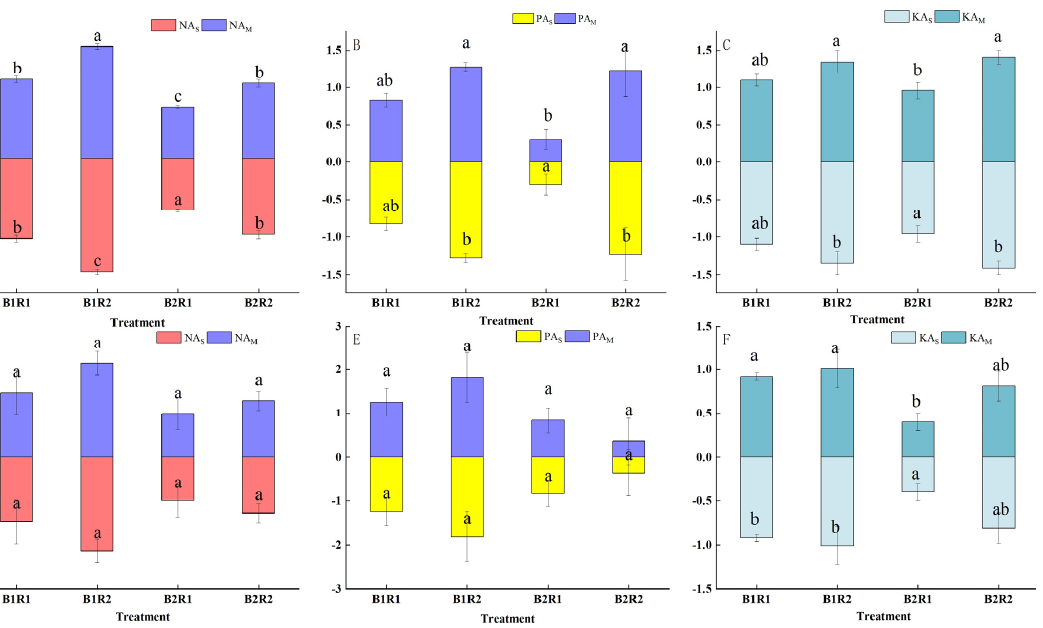
Figure 5. Nutrient aggressivity of maize–soybean intercropping systems. ( A – C ) represent intercropped maize and intercropped soybean N, P, and K aggressivities in 2018, respectively. ( D – F ) represent intercropped maize and intercropped soybean N, P, and K aggressivities in 2019, respectively. lowercase letters above the bars indicate significant differences ( p < 0.05). Values are means ± standard error.